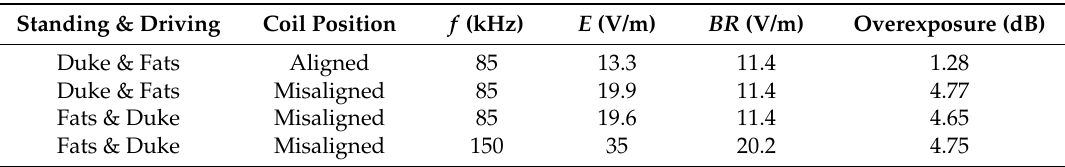
Table 5. Comparison of the peak induced electric field averaged over a 2 × 2 × 2 mm 3 cube and the BR for the considered exposure